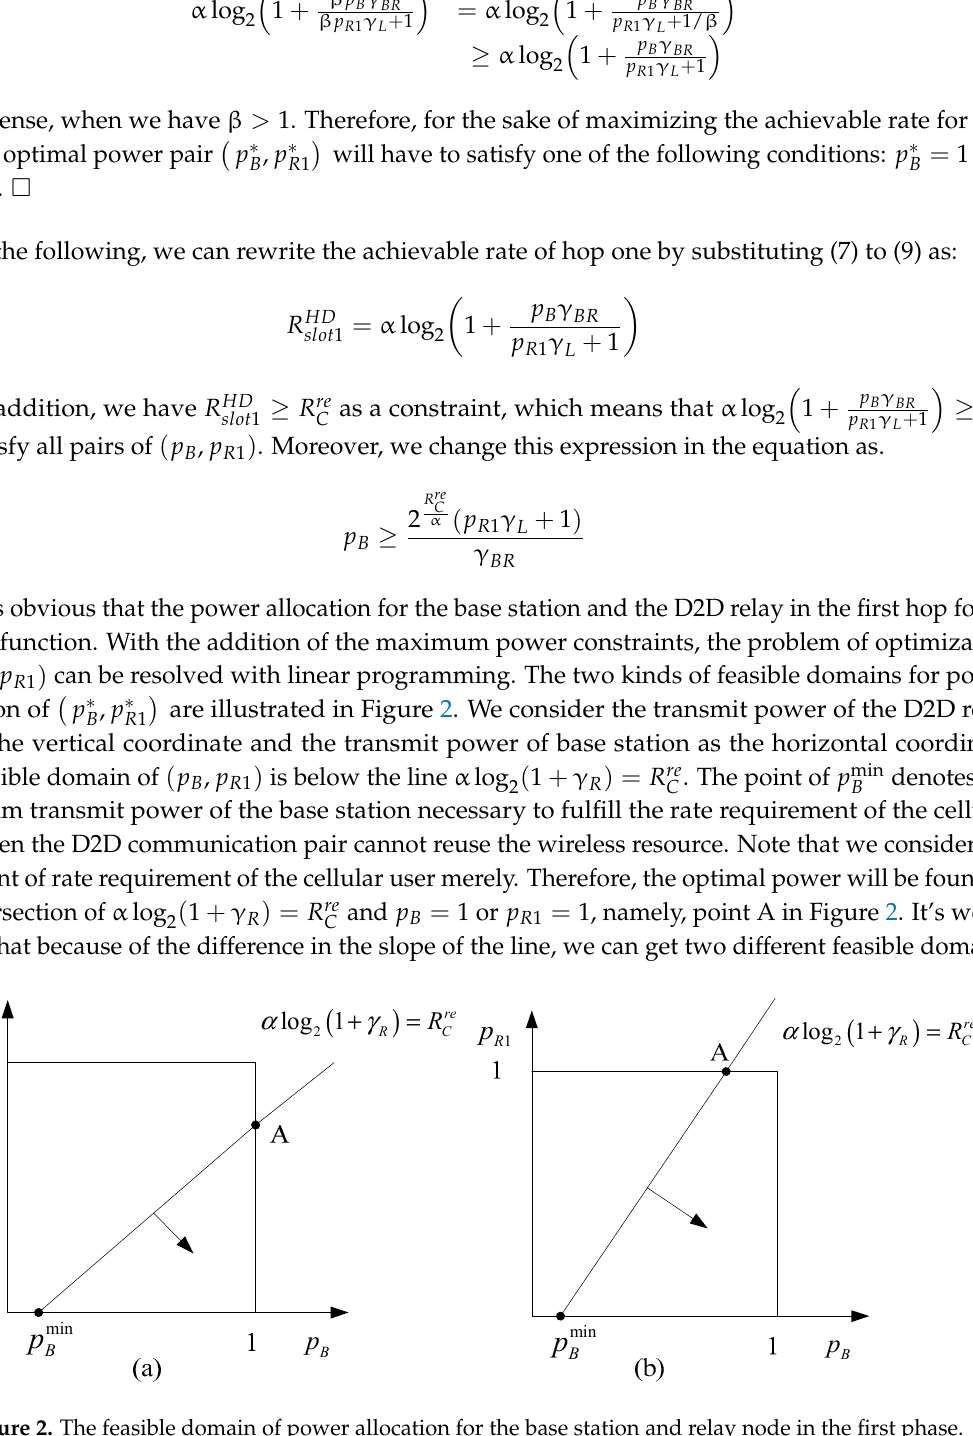
Figure 2. The feasible domain of power allocation for the base station and relay node in the first phase.